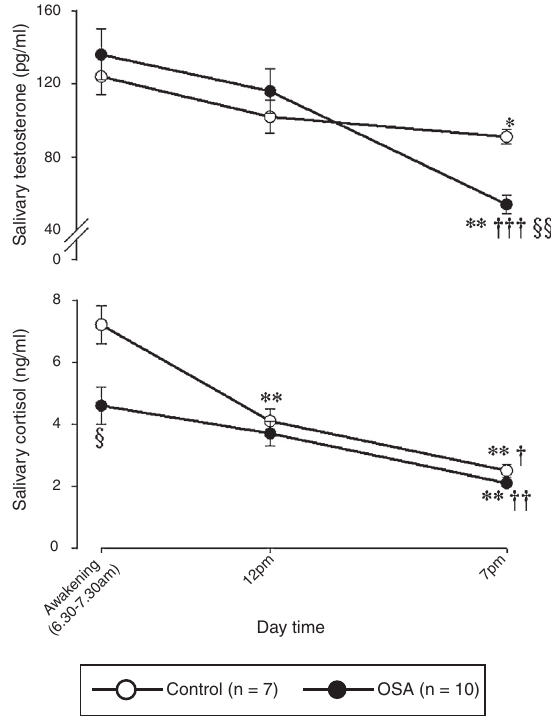
Figure 1 Diurnal trajectories of salivary free-testosterone and salivary free-cortisol in the study population. The data are presented as the mean ± SEM. Statistical analysis: a two- way ANOVA followed by post-hoc test for multiple comparisons: * and **: p < 0.05 and p < 0.01, respectively, vs. the value at 07:00; † , †† , and ††† : p < 0.05, p < 0.01, and p < 0.001, respec- tively, vs. the value at 12:00; § and §§ : p < 0.05 and p < 0.01, respectively, vs. the control.